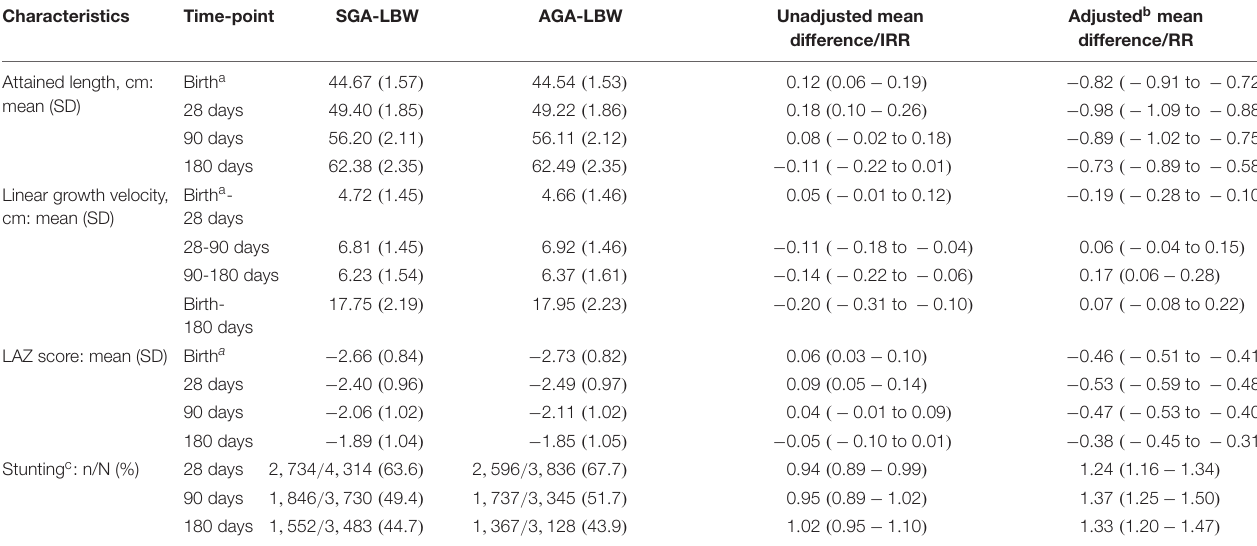
TABLE 1 | Linear growth patterns in small for gestational age (SGA) and appropriate for gestational age (AGA) low birthweight infants at different time points. Characteristics